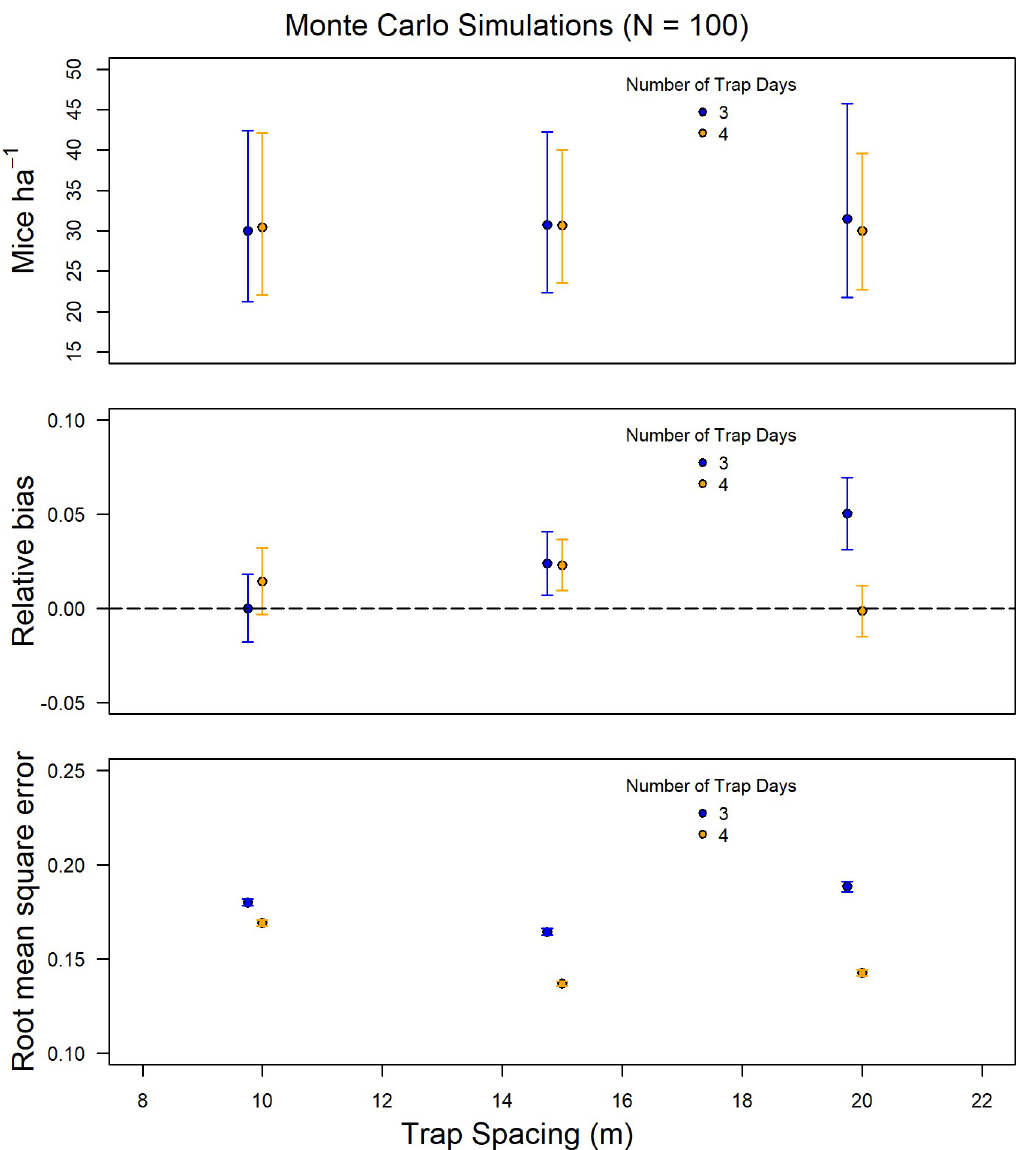
Fig 6. Density estimate, relative bias, and root mean square error for Monte Carlo simulations (n = 100) using the mean density, detection funtion, and home range as the true values for comparing the number of trapping occasions (3, 4), and trap spacing (10, 15, 20